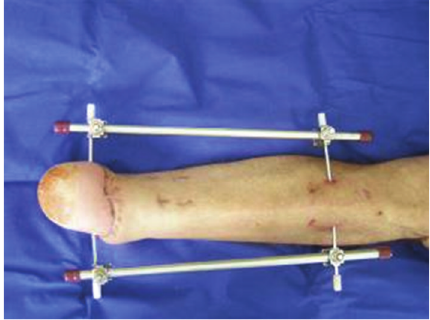
Figure 2: Temporary fixation by fixateur externe.